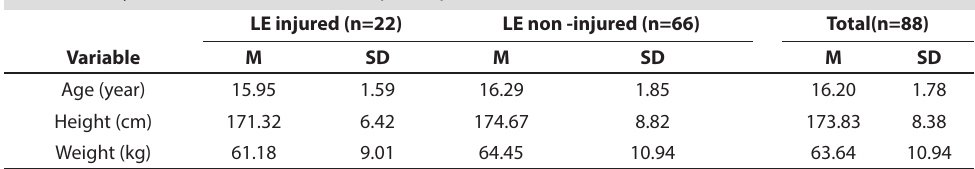
TABLE 1 Physical Characteristics of the